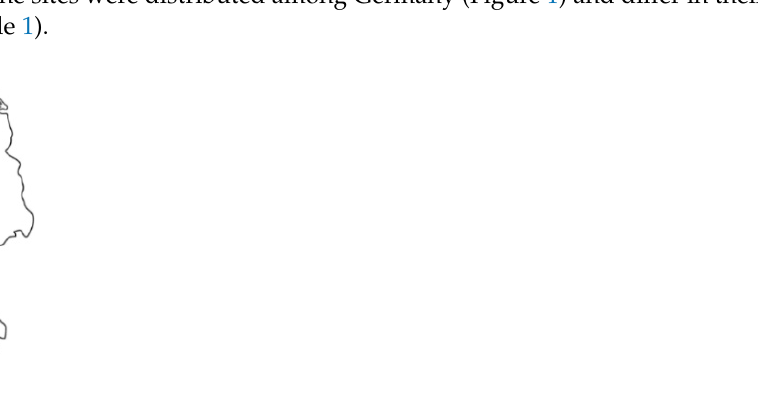
Figure 1. Location of the four study sites Tachenhausen (TH), Haus Düsse (HD), Wehnen (WN), and Obershagen (OH) in Germany. Table 1. Conditions of the four study sites.